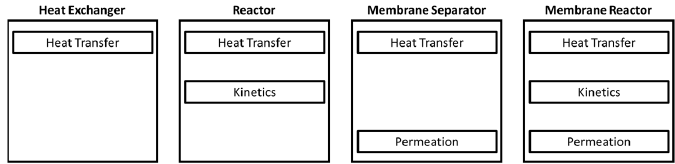
Figure 1. Example of a module-based design with a reactor module (R), membrane reactor (MR), and membrane separator (M).